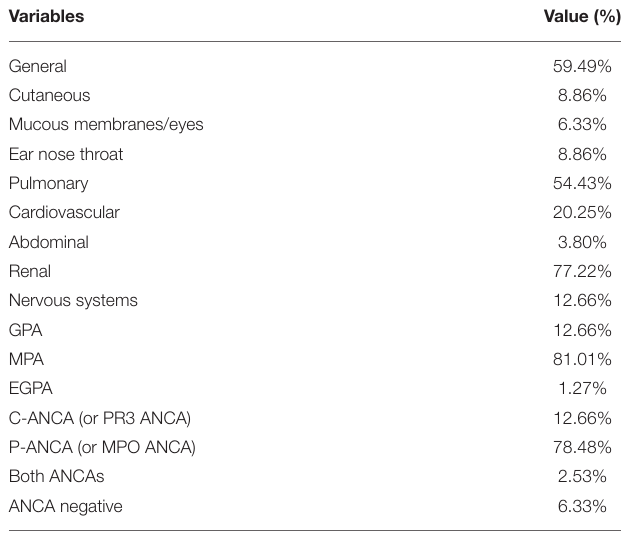
TABLE 2 | Baseline clinical menifestation of AAV